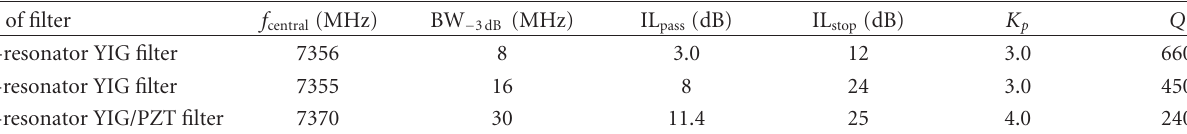
Table 1: Characteristics of one-resonator and two-resonator band-pass filter.